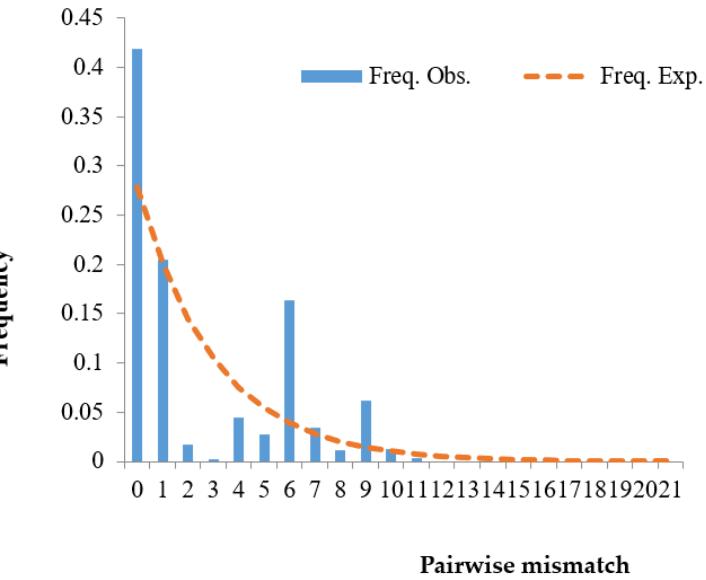
Figure 2. Mismatch distribution of the Colletotrichum gloeosporioides population from Citrus in China. Exp stands for expected value and Obs stands for observed value.